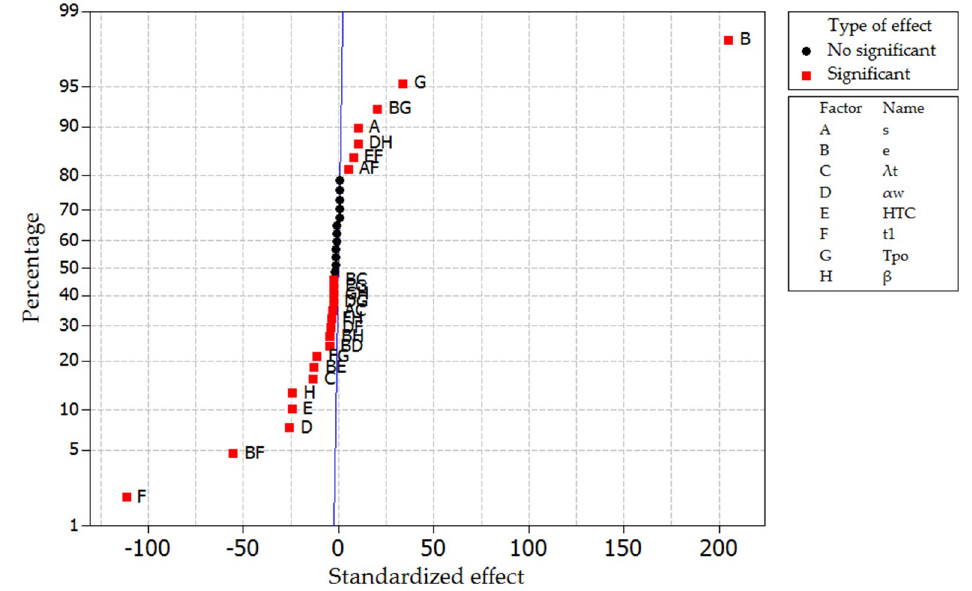
Figure 8. Normal graph of standardized effects.